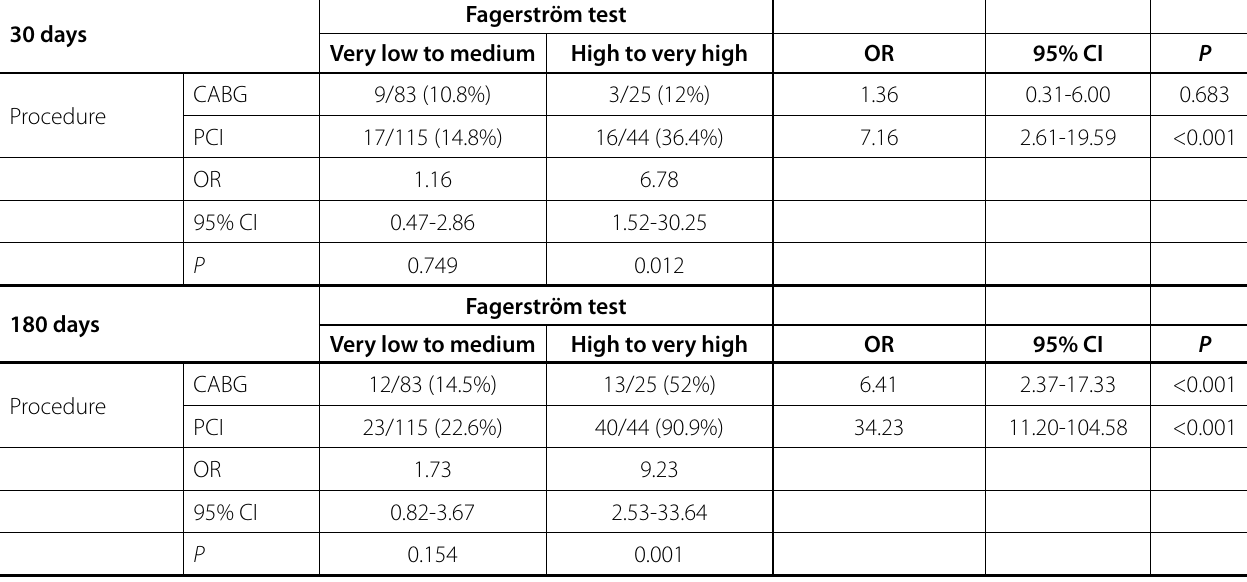
Table 5. Stratified analysis of the interaction between variables "Procedure" and "Fagerström test" in the relapse of smoking. 30 days